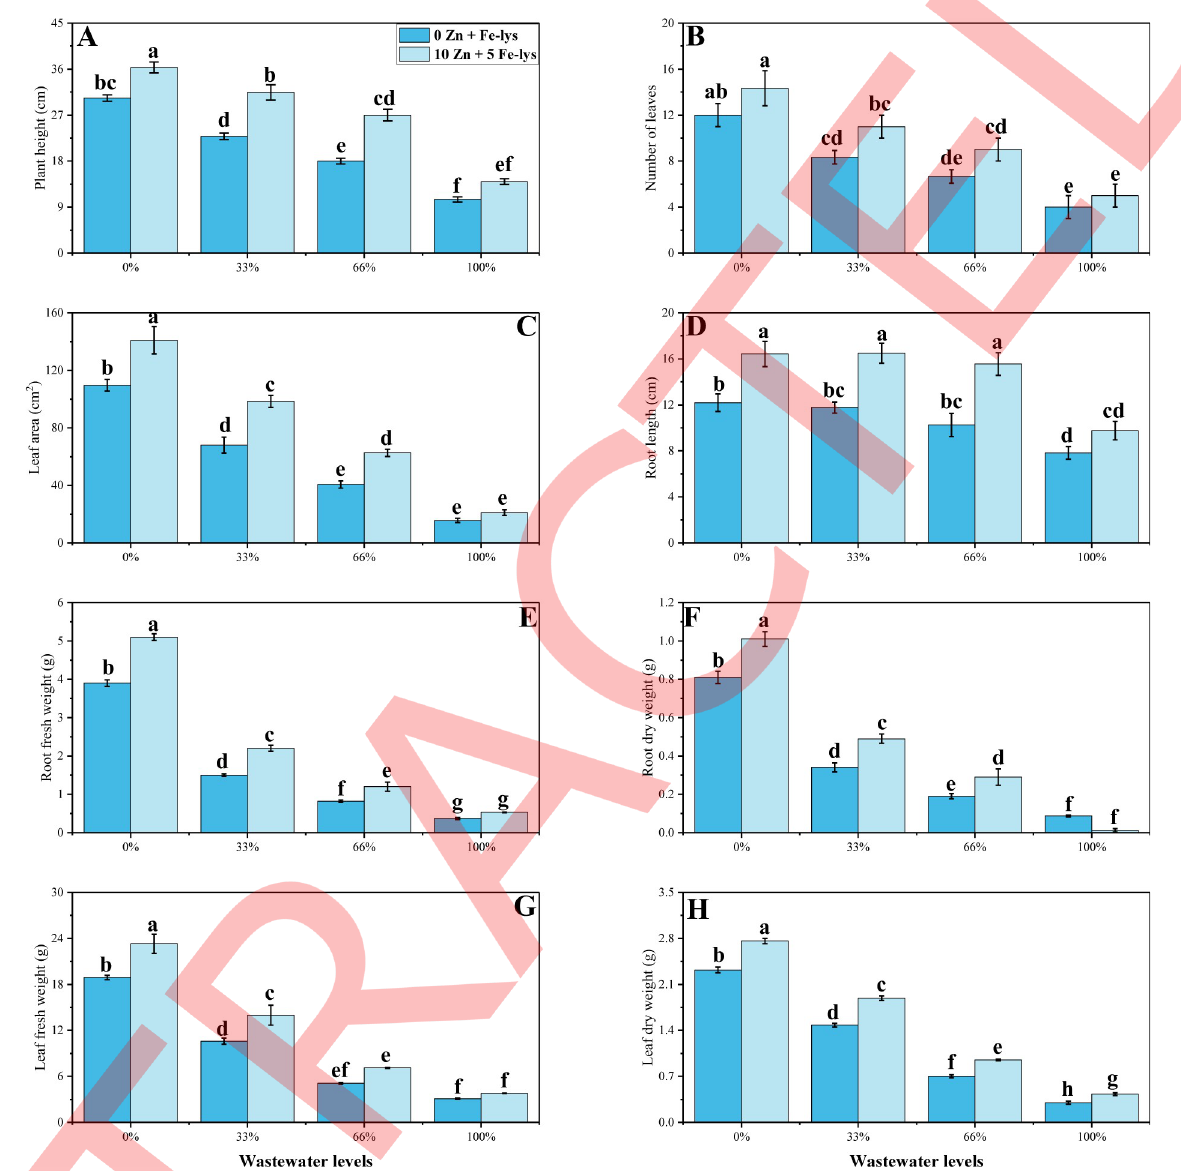
Fig 1. Effect different levels of tannery wastewater on plant height (A), number of leaves (B), leaf area (C), root length (D), root fresh weight (E), root dry weight (F), leaf fresh weight (G) and leaf dry weight (H) under the application of Zn and Fe-lys on B . napus . Values are demonstrated as means of three replicates along with standard deviation (SD; n = 3). One-way ANOVA was performed and means differences were tested by HSD ( P < 0.05). Different lowercase letters on the error bars indicate significant difference between the treatments. Different levels of tannery wastewater used are as follow: 0 (without irrigation with wastewater), 33 (33% irrigation with wastewater), 66 (66% irrigation with wastewater) and 100 (100% irrigation with wastewater).